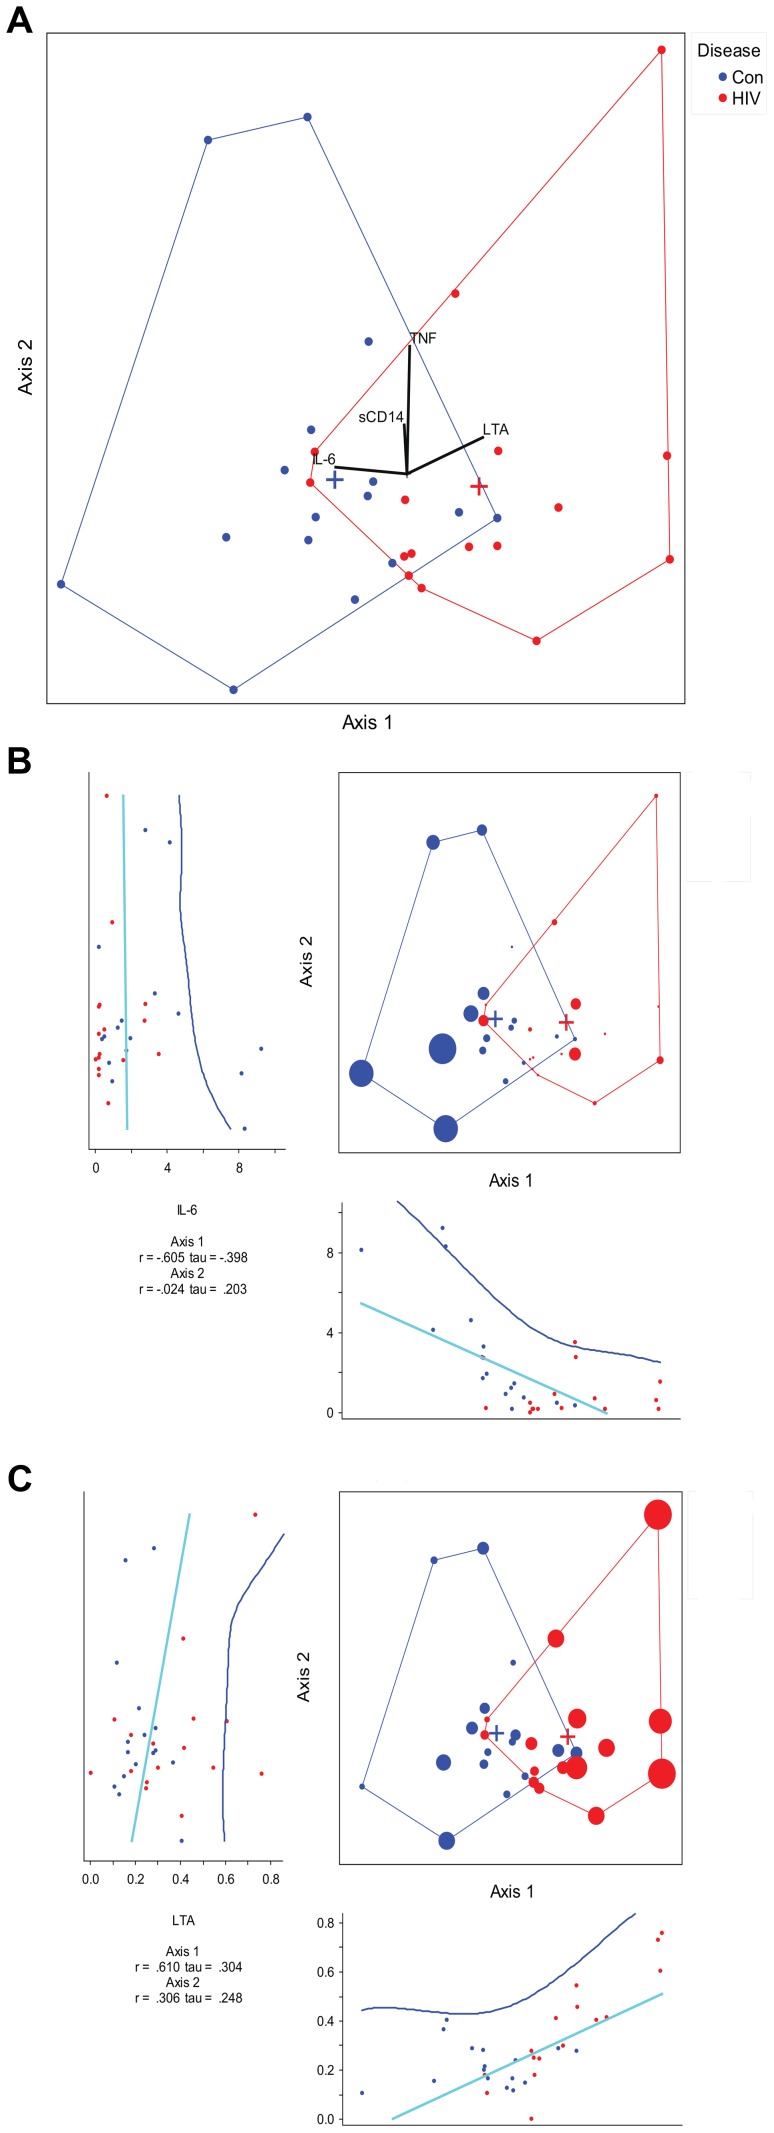
Canonical correspondence analysis of genera with measured cytokines.HIV samples are shown in red vs. control samples are shown in blue. (a)The eigenvalues for axis 1 and axis 2 are 0.107 and 0.087, respectively. The axes 1 and 2 explain 2.8% and 2.2% of the total variance, respectively. The first canonical axis is statistically significant with p = 0.003 using a randomization test where p = proportion of randomized runs with eigenvalue greater than or equal to the observed eigenvalue with 998 randomizations. The vectors in the mid portion of the graph represent cytokines or microbial translocation products. LTA increases going toward the HIV group, and IL-6 increases going toward the control group. The effect of TNF and sCD14 are minimal along the first axis of separation between the cases. (b) Canonical correspondence analysis of genera with IL-6 effect overlay. The size of the case dots correspond to the impact of IL-6 on the analysis. The regression plot for each axis coordinates and IL-6 is given below the axis for axis 1 and to the left of the axis for axis 2. (c) Canonical correspondence analysis of genera with LTA effect overlay. The size of the case dots correspond to the impact of LTA on the analysis. The regression plot for each axis coordinates and LTA is given below the axis for axis 1 and to the left of the axis for axis 2.